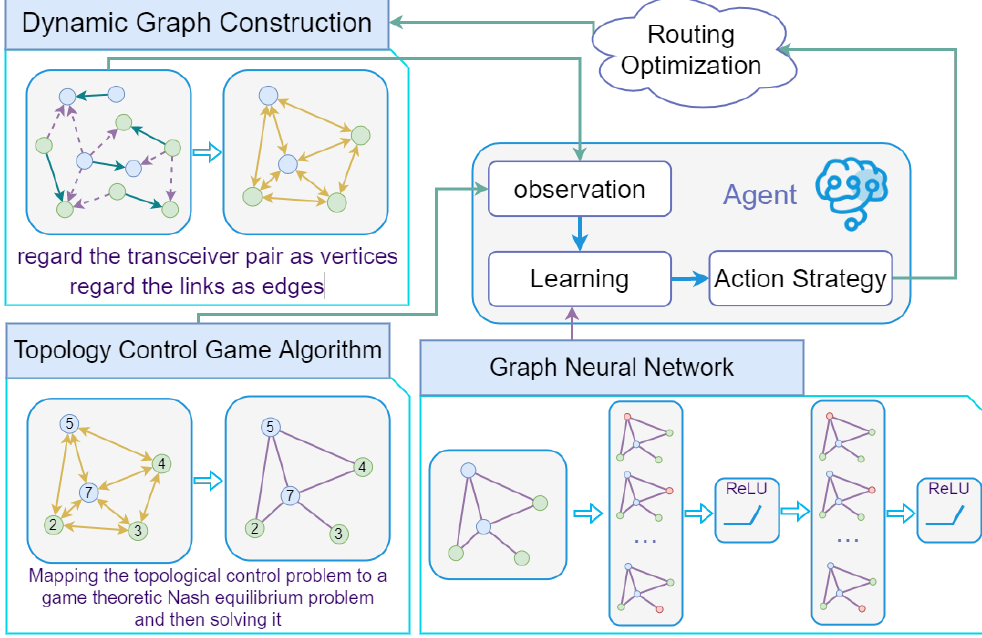
Figure 5. The deep reinforcement learning